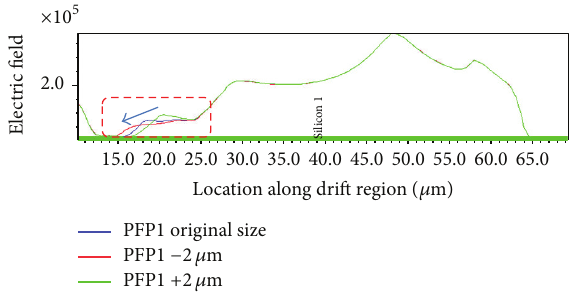
Figure 5: Lateral electric field distribution of different PFP1 size.